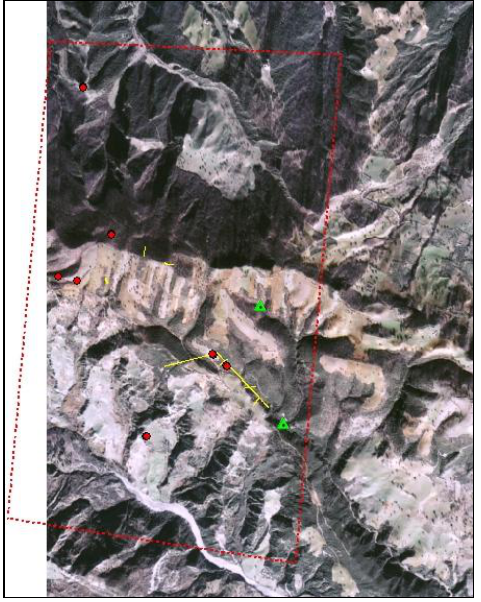
Figure 1. Test area Ikonos +